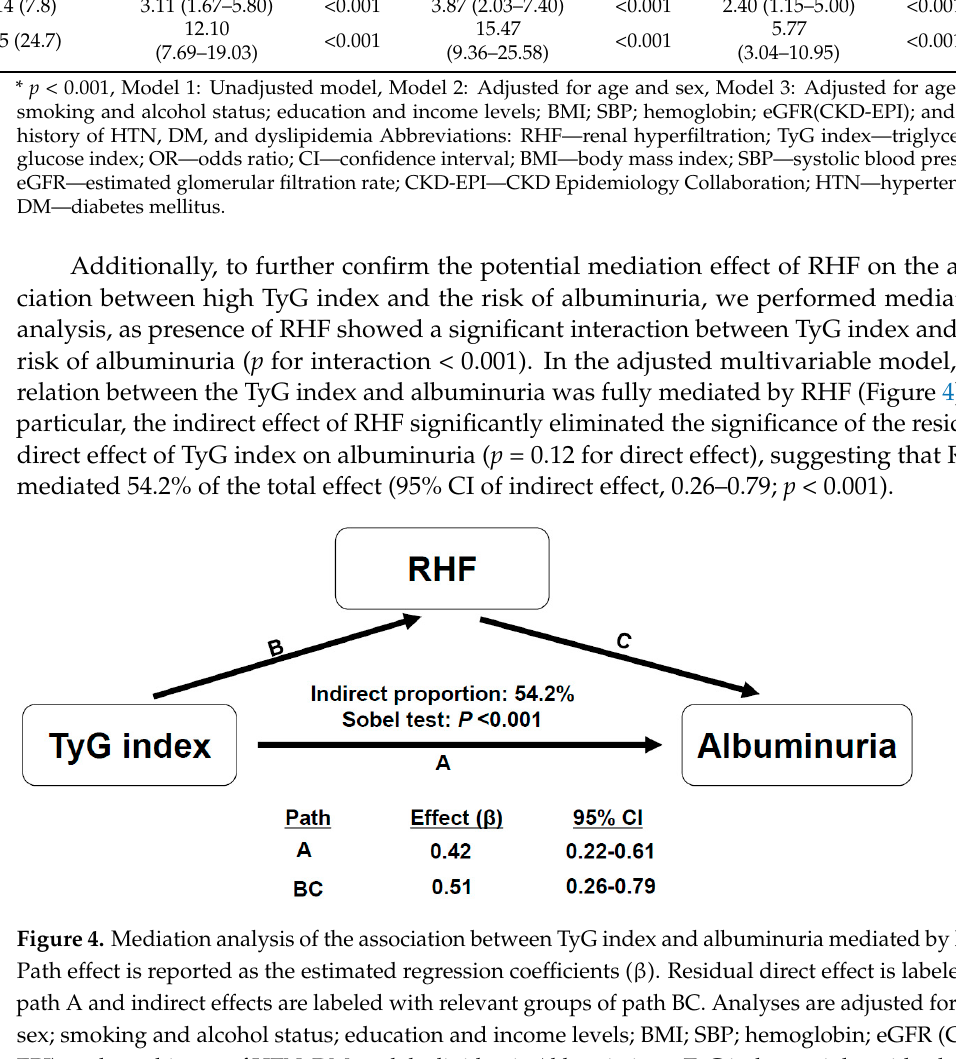
Comparison was performed using ROC analysis. * Basic model includes traditional risk factors for CKD such as age; sex; smoking and alcohol status; education and income levels; BMI; SBP; hemo- globin; eGFR; and past history of HTN, DM, and dyslipidemia. # p value for the improvement of predictive power of basic model + TyG index compared with the basic model. Abbreviations: